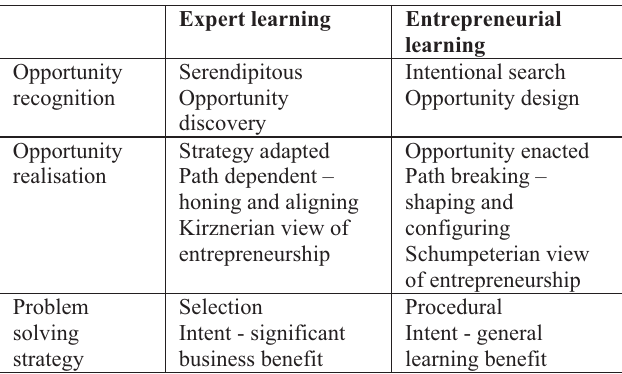
Table 4: Characteristics of expert learning